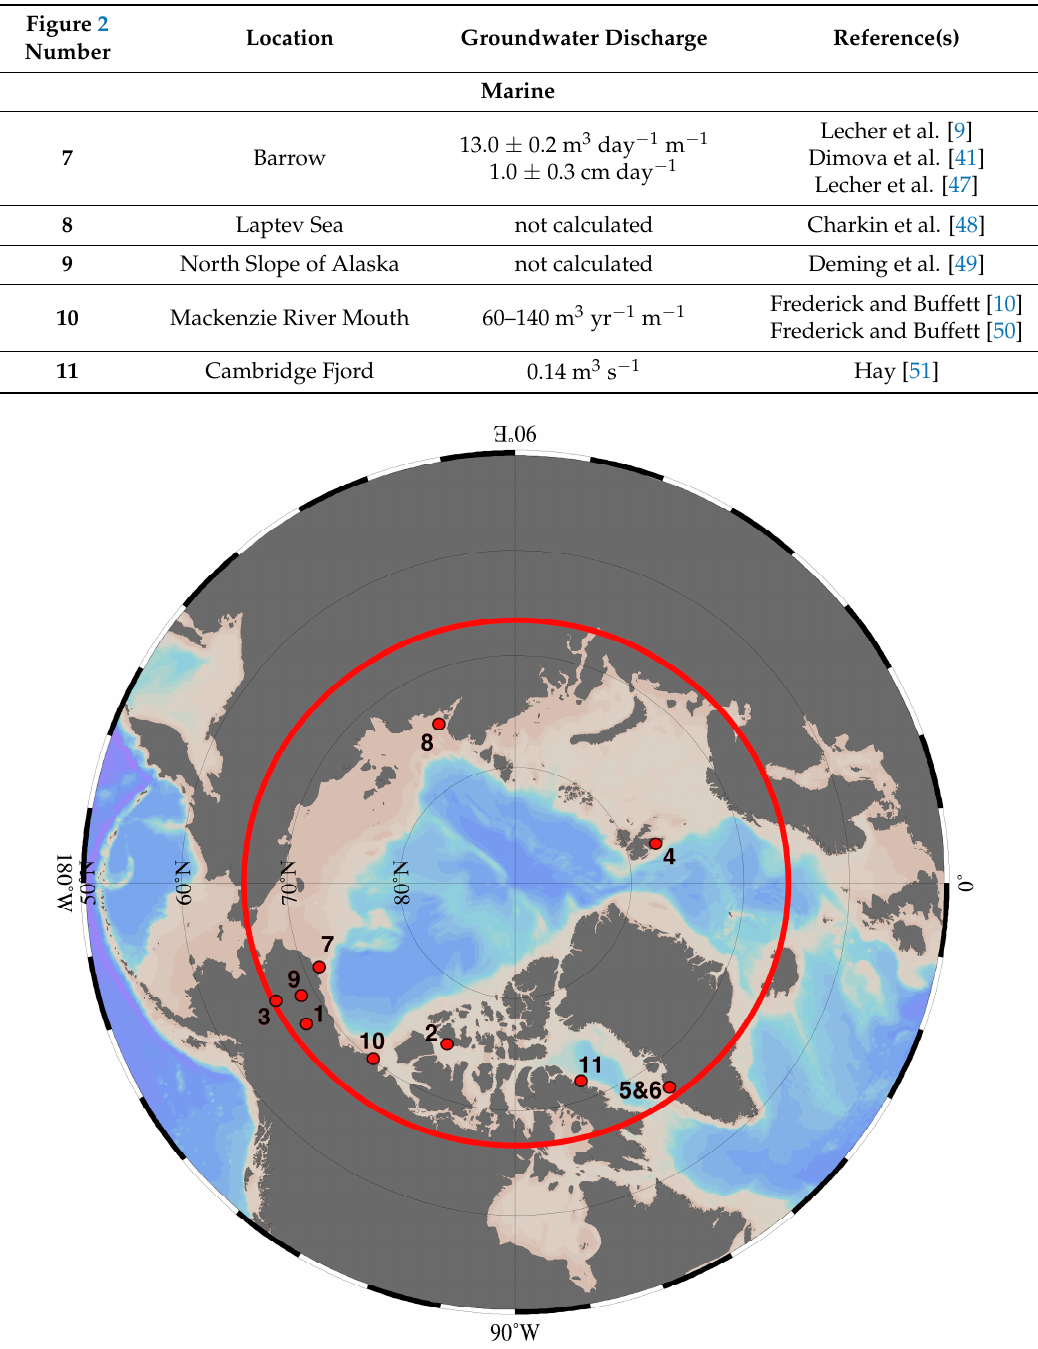
Figure 2. Locations of studies, as viewed from the geographic North Pole. Numbers correspond to the study sites in Table 1. Figure made using Ocean Data View (Schlitzer, R., Ocean Data View, http://odv.awi.de, 2016).